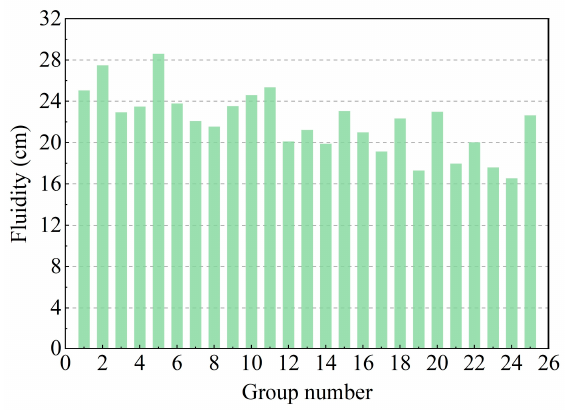
Figure 9. Test results of fluidity.